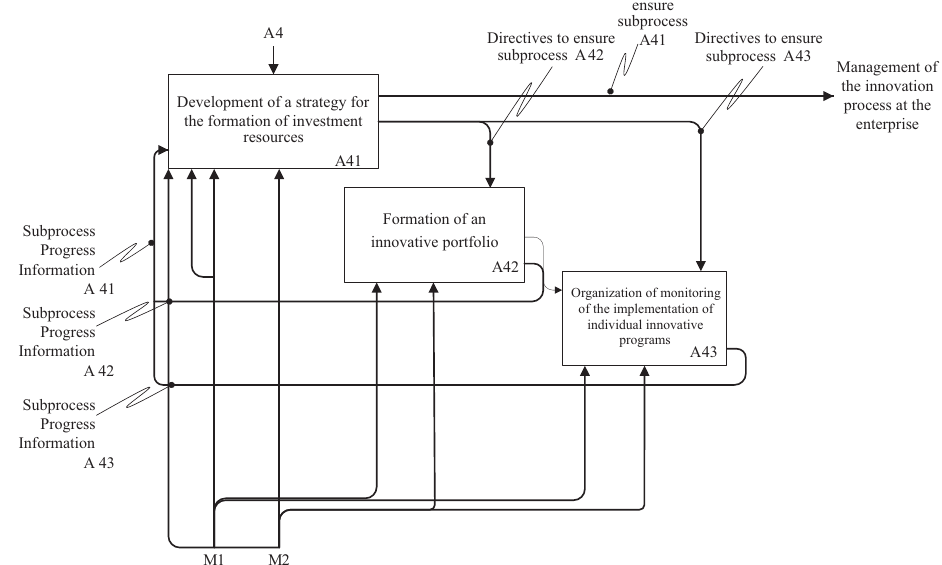
Figure 7. The decomposition of the functional model for achieving the process